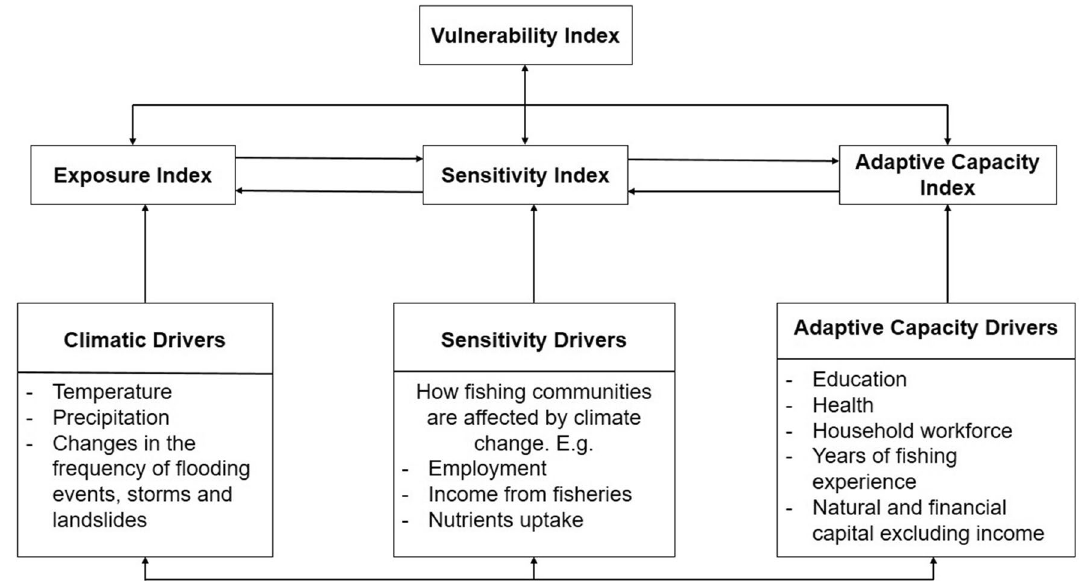
Fig. 1 Schematic representation of the vulnerability conceptual framework. Source: Authors’